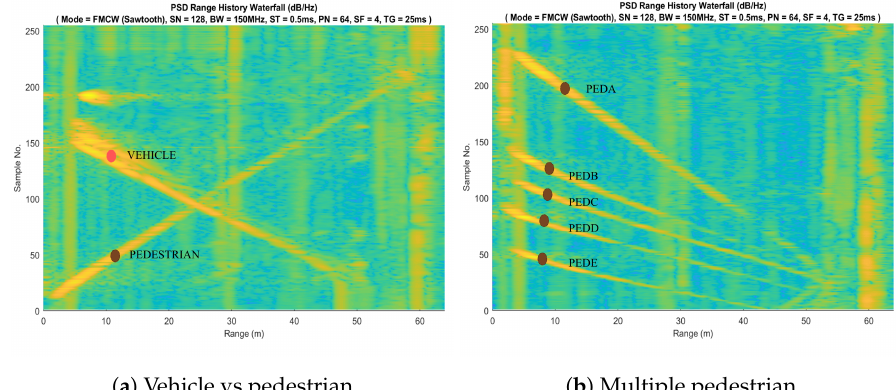
Figure 11. Phase 1 and Phase 2 field test area satellite view.